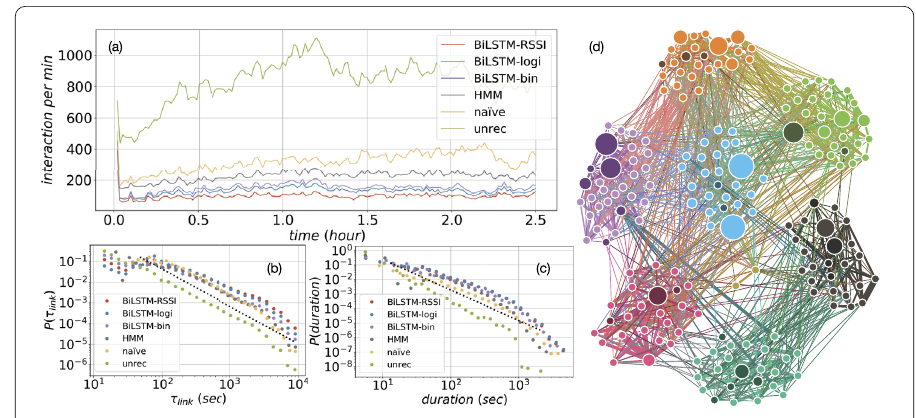
Figure 5 Characterisation of the reconstructed network. ( a ) Rates of reconstructed events by different methods (for colours see key). ( b ) Inter-event time distribution between original and reconstructed event on single links. ( c ) Distribution of the duration of interactions. Dashed lines on panels ( b ) and ( c ) depict approximating power-law functions with exponents 1.8 and 2.1 respectively. ( d ) Weighted static representation of a reconstructed network using the BiLSTM-RSSI method. Here link widths are proportional to the time spent together when both nodes were present and node sizes are proportional to node degrees. Nodes are coloured according to the original class partitions with darker nodes indicating adults (teachers, assistants or interns). For better visualisation we removed links which correspond to the weakest 3% of